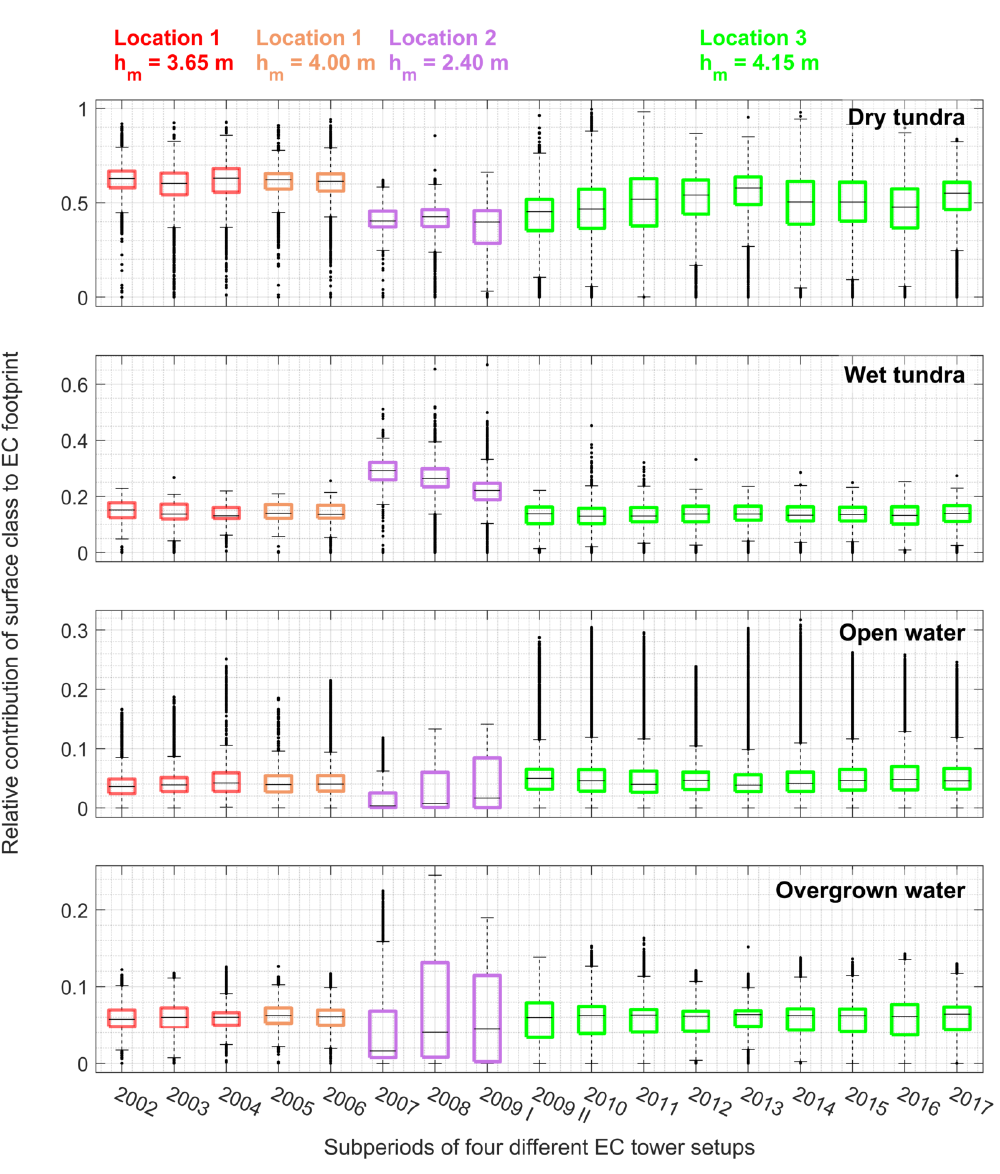
Figure 7. Mean surface class composition of the eddy covariance footprint during 17 subperiods of four different tower setups at three locations on Samoylov